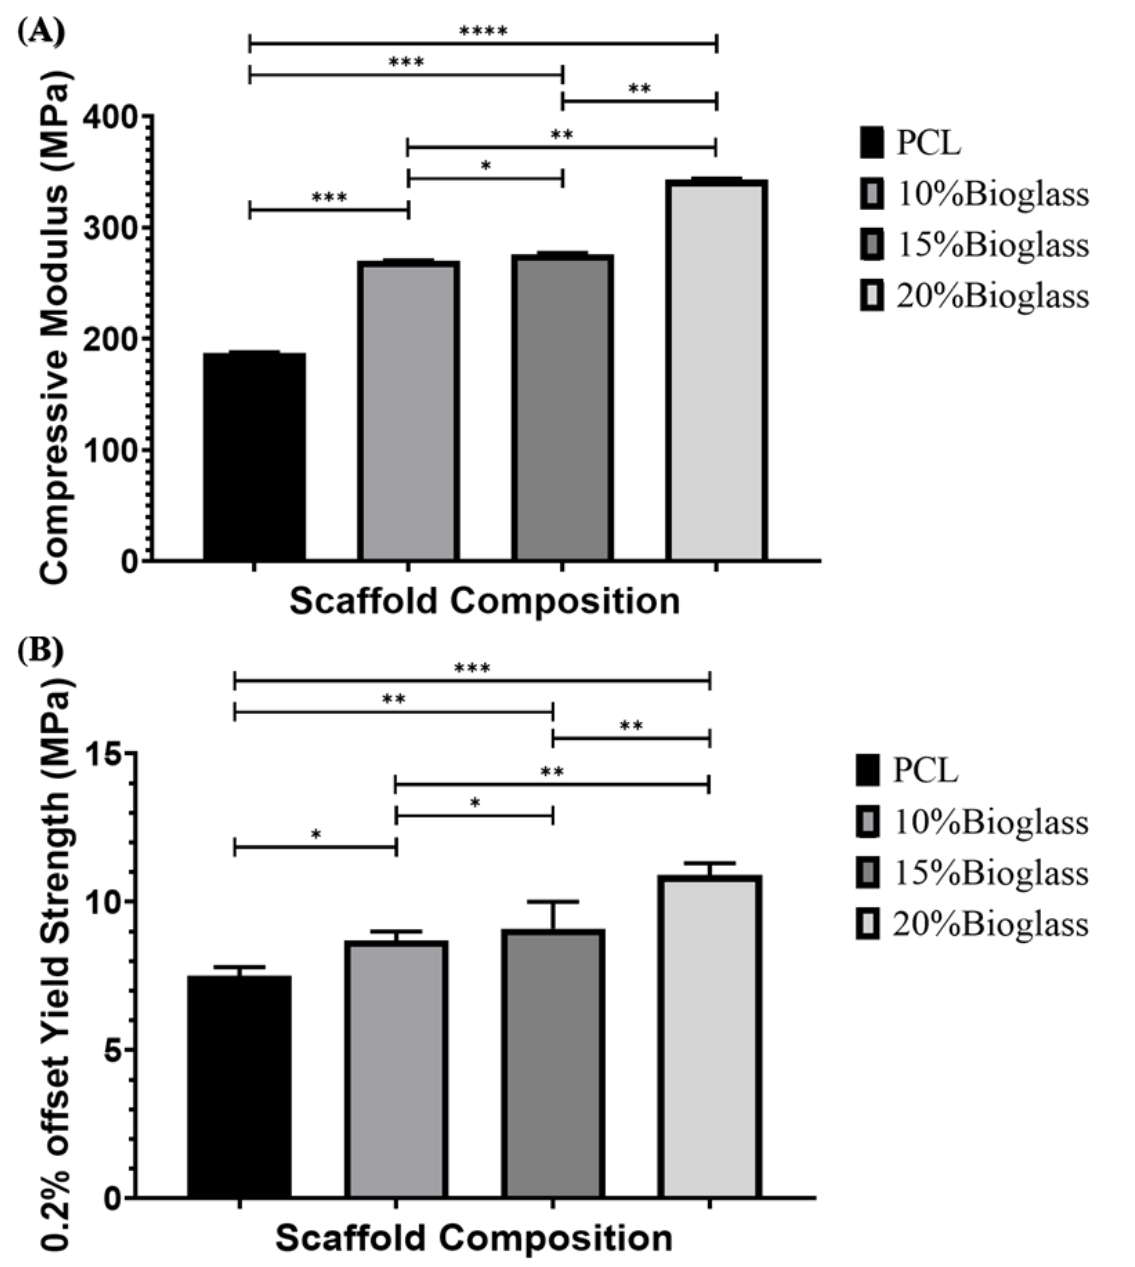
Figure 11. ( A ) The compressive modulus and ( B ) 0.2% offset yield strength results as a function of bioglass content. * Statistical evidence ( p < 0.05) analysed by one-way ANOVA, and Tukey post hoc test. The * statistical evidence ( p < 0.05), **, *** and **** is the one-way analysis of variance (one-way